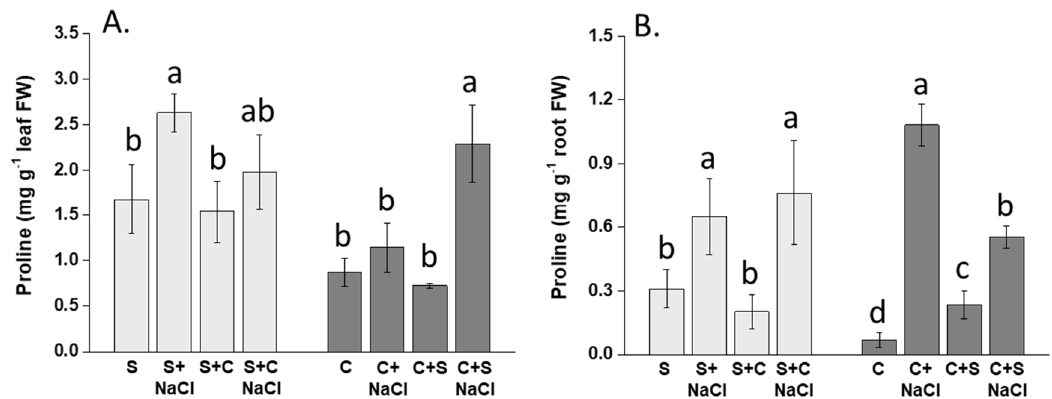
Figure 10. Proline content in leaves ( A ) and roots ( B ) of soybean and C. album , treated and nontreated with NaCl. Different letters within each group of bars indicate significant differences at p < 0.05, n = 3. S = soybean; C = C. album , FW = fresh weight. The experiment was replicated twice, and only data from one representative experiment are shown.